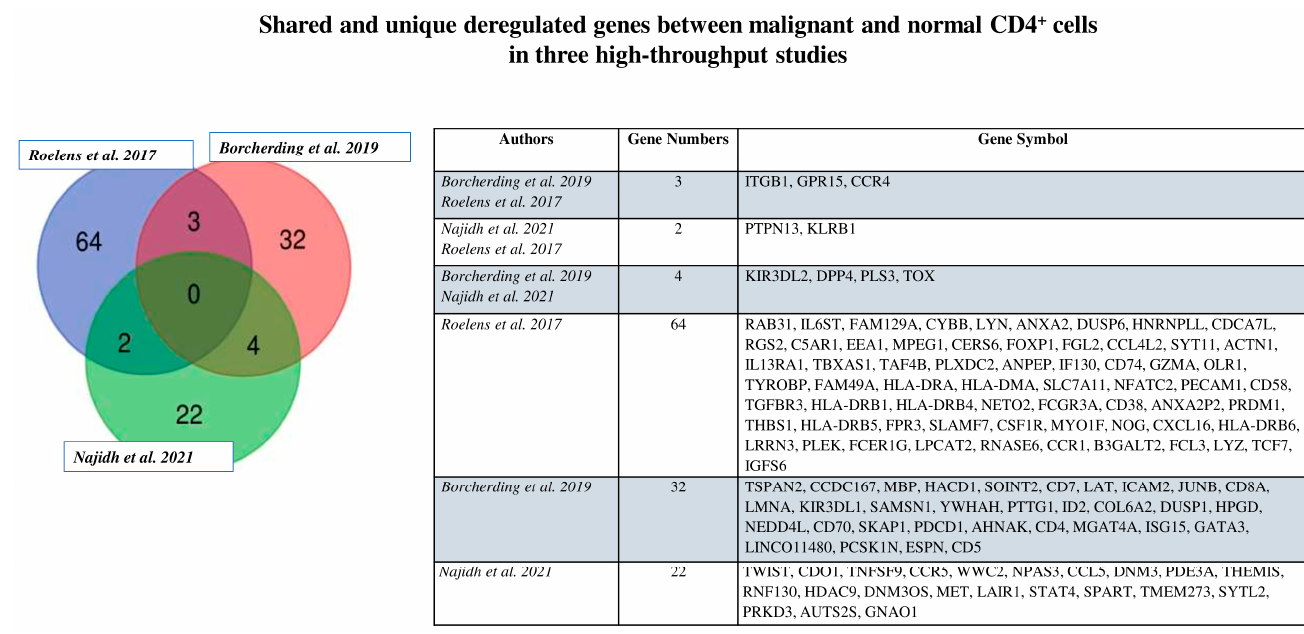
Figure 3. Shared and unique deregulated genes between malignant and normal CD4+ cells in three high-throughput studies.